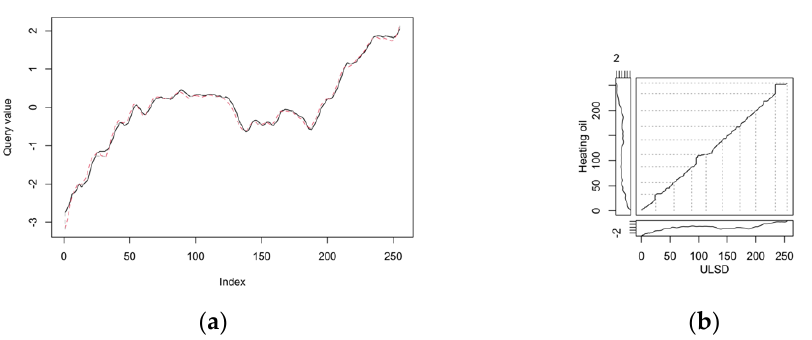
Figure 11. Alignment plots for ULSD and heating oil for the second subperiod. ( a ) Two-way, ( b ) Three-way. On the two-way plot the black solid line for ULSD, the red dashed line for heating oil. Source: own elaboration on the basis of data from www.stooq.com (accessed on 19 April 2021).